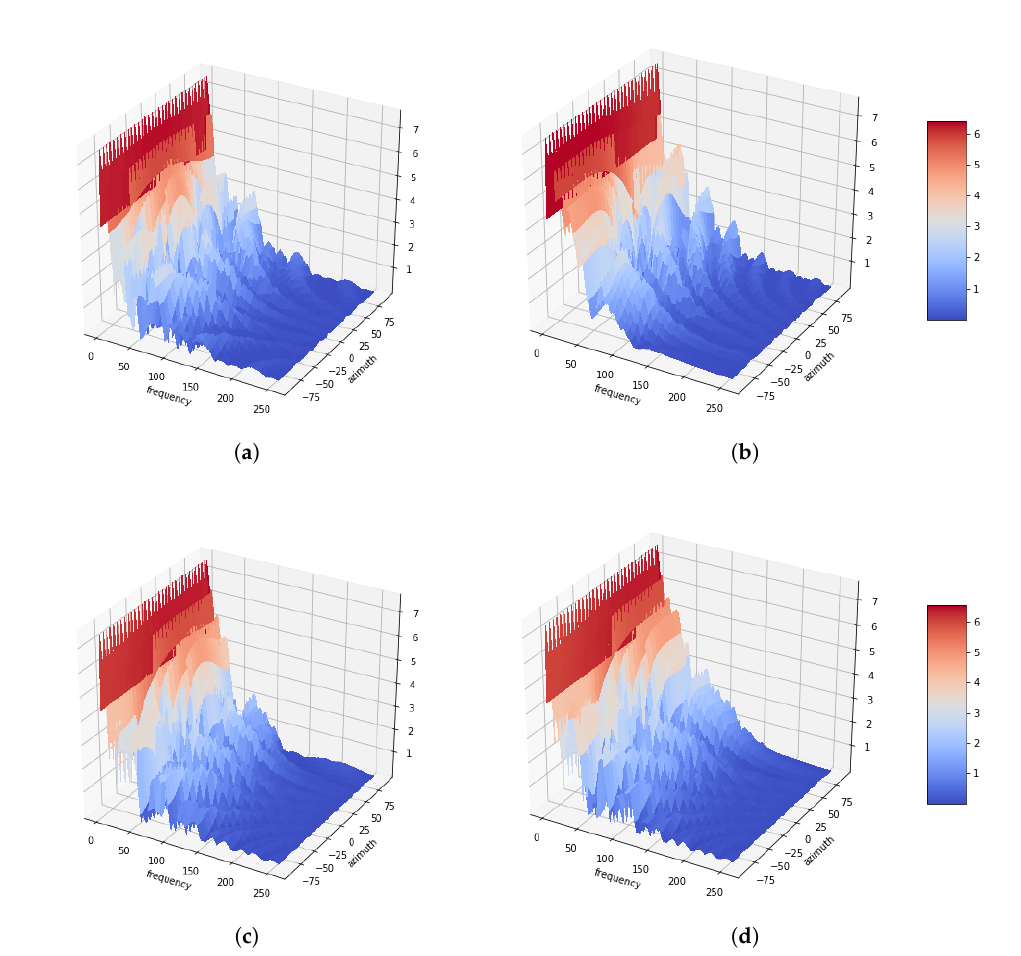
Figure 2. Azimuth-frequency representation of speech signal depending as a function of the